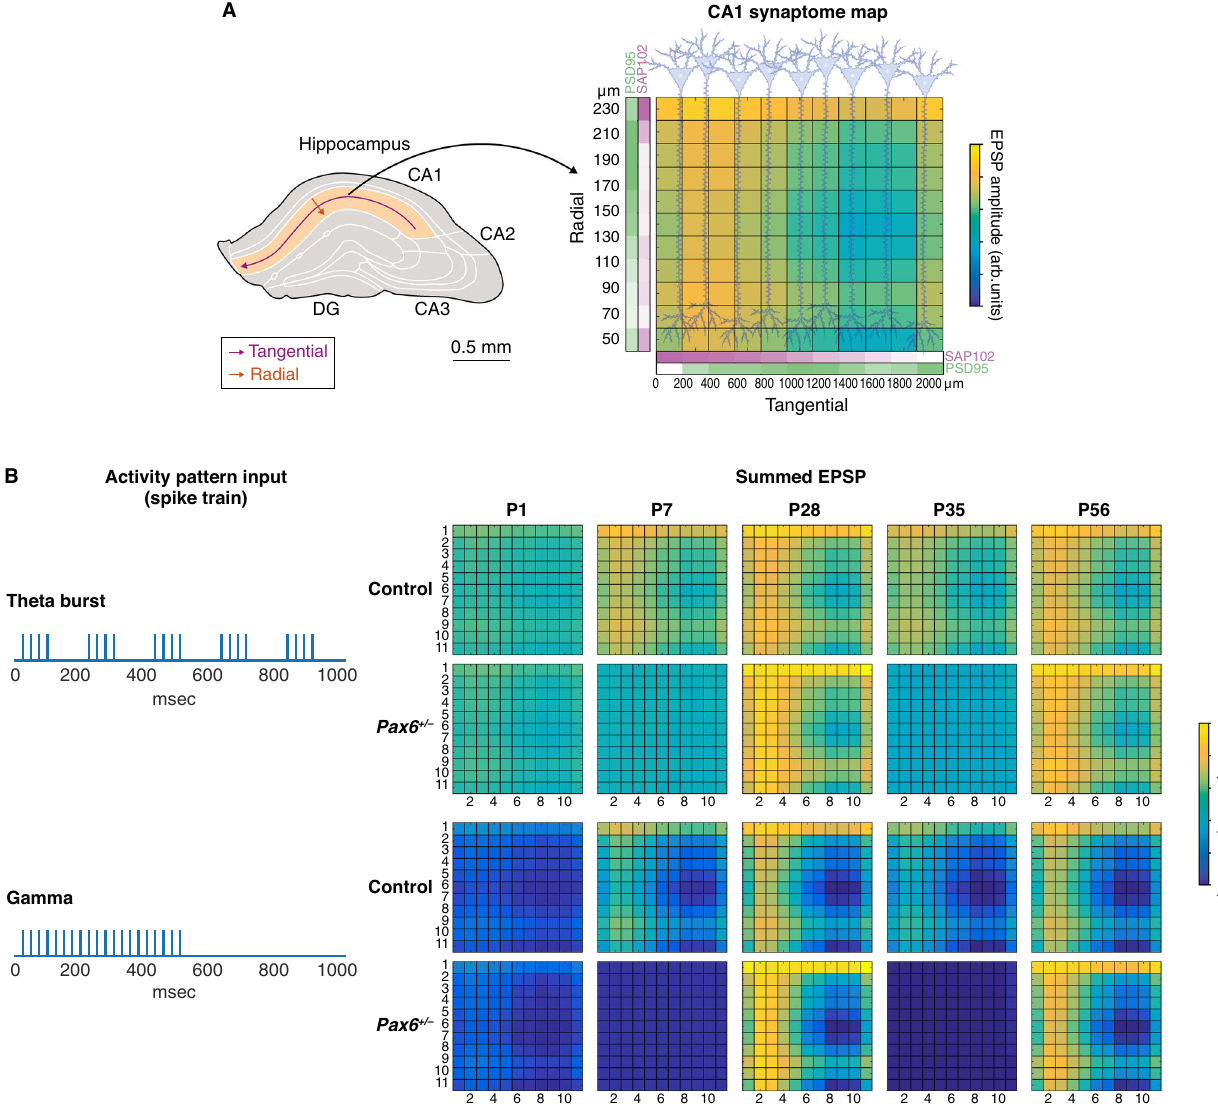
Fig. 6 | Altered synaptic responses to physiological spike patterns in the Pax6 mutantmouse.A SynapticPSD95andSAP102amounts(intensity)alongtheradial andtangentialdirectionsoftheCA1stratumradiatum,withintensitysymbolizedby color intensity; PSD95 (green) and SAP102 (magenta) were used as in previous work 2,3 to set synaptic properties of the computational model. Synaptic EPSP amplitudes of age groups (P1 – P56) and genotype (control, Pax6 +/ − ) were scaled